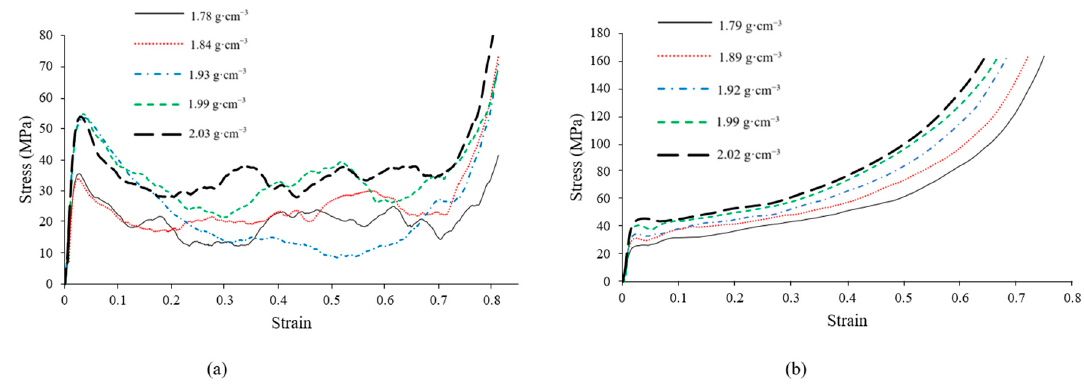
Figure 7. Compressive stress-strain curves of ( a ) as-cast and ( b ) heat-treated ZA27 syntactic foams with different